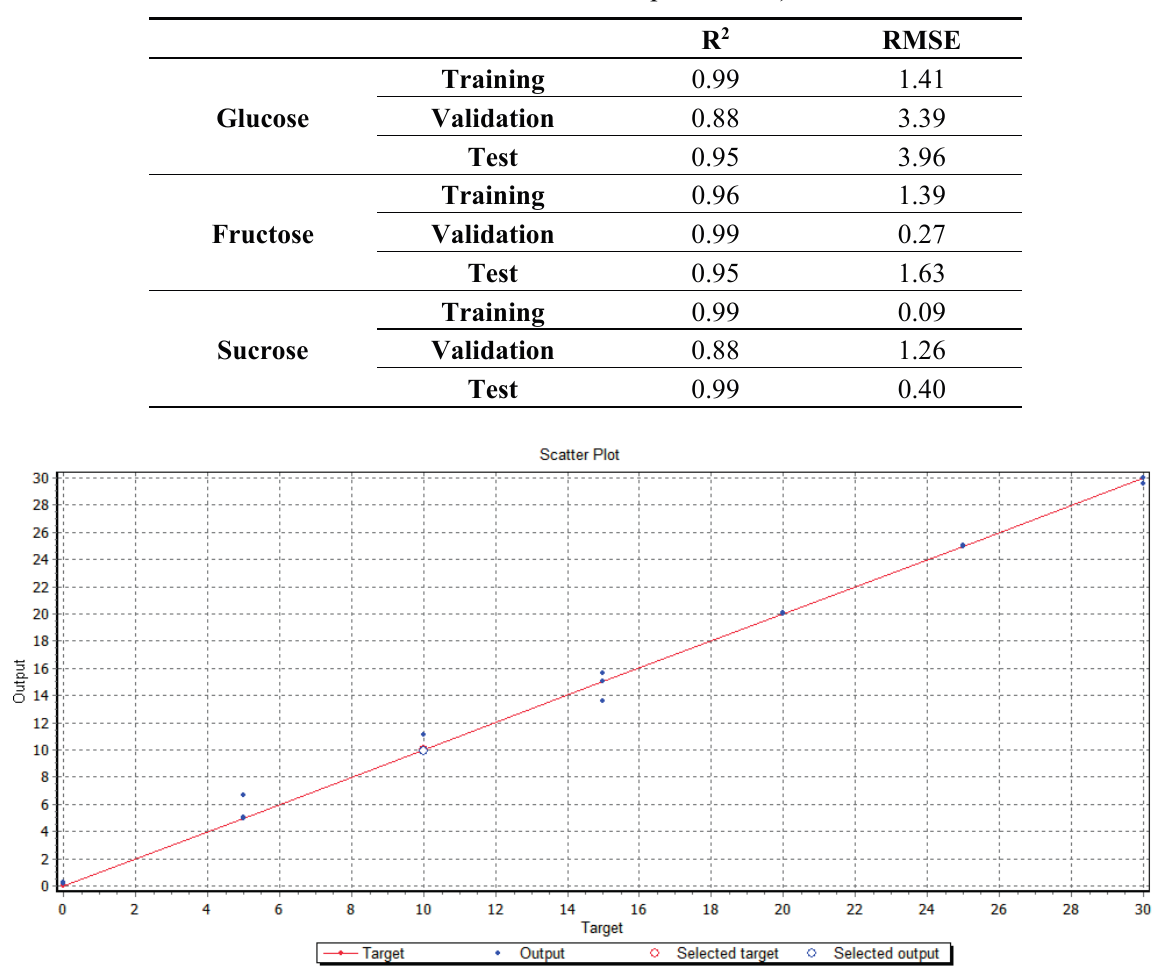
Table 2. Artificial neural network (ANN) results for the studied fermentable sugars (R 2 : coefficient of determination; RMSE: Root Mean Square Error).